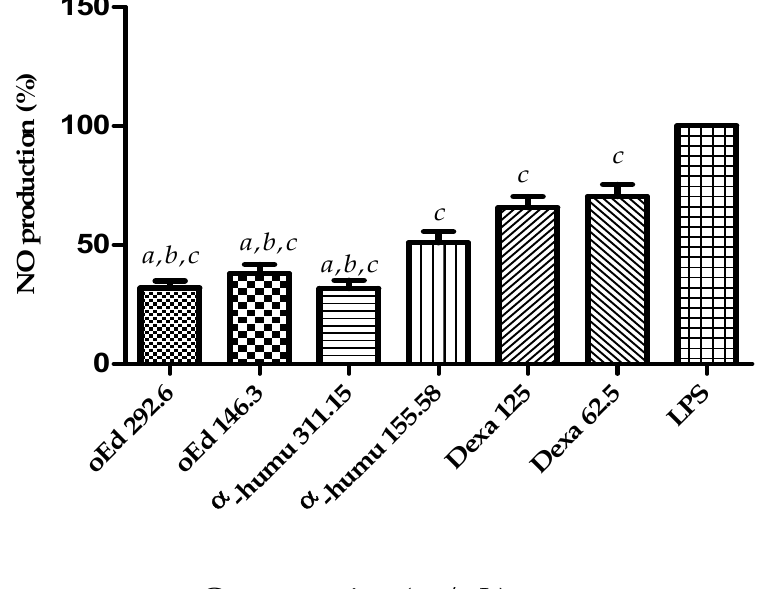
Figure 5. Effects of essential oil from E. dysenterica leaves on LPS-induced NO in RAW 264.7 using the Griess assay. Macrophages were incubated in the presence of oEd, α -humulene or dexamethasone in combination with 1 µ g/mL LPS for 48 h. The significant differences related to the concentration values of essential oil (oEd); α -humulene ( α -humu) and dexamethasone (Dexa) from the inhibition of nitric oxide production of following LPS-stimulation. Values in three experiments were calculated by one-way ANOVA with Bonferroni’s Multiple Comparison Test ( a p < 0.05 vs. Dexa 125. b p < 0.05 vs. Dexa 62.5. c p < 0.05 vs. LPS).